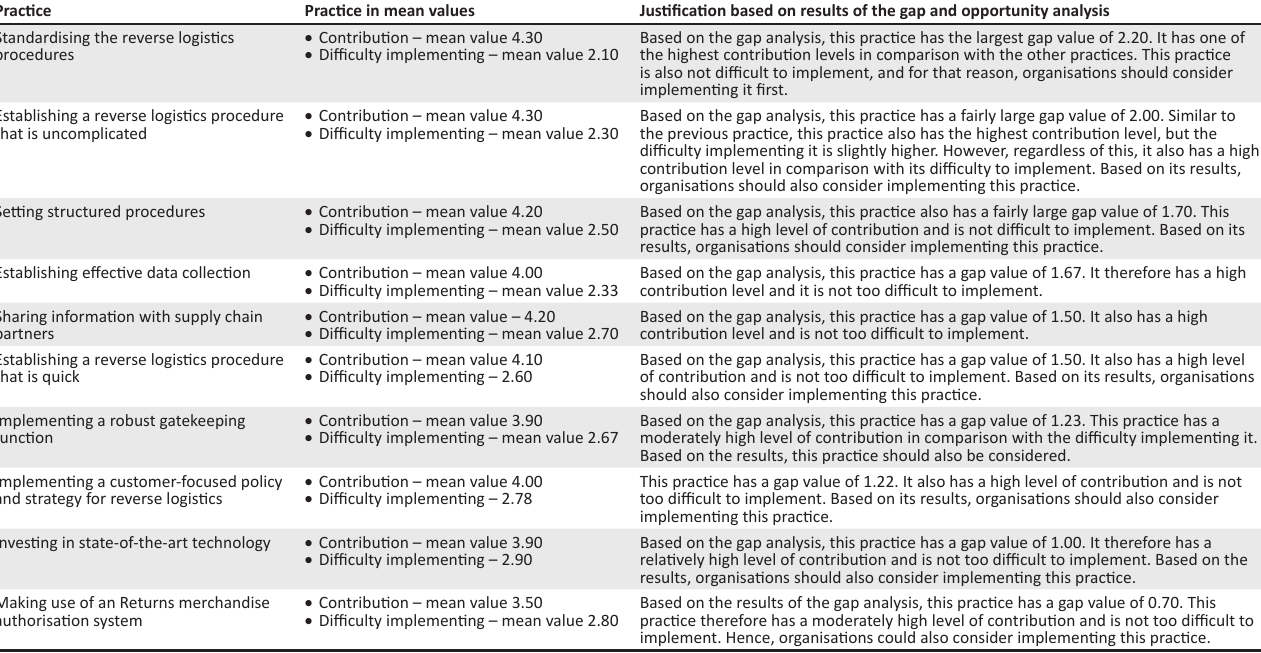
TABLE 2: Reverse logistics practices in the Pearl quadrant: First priority.